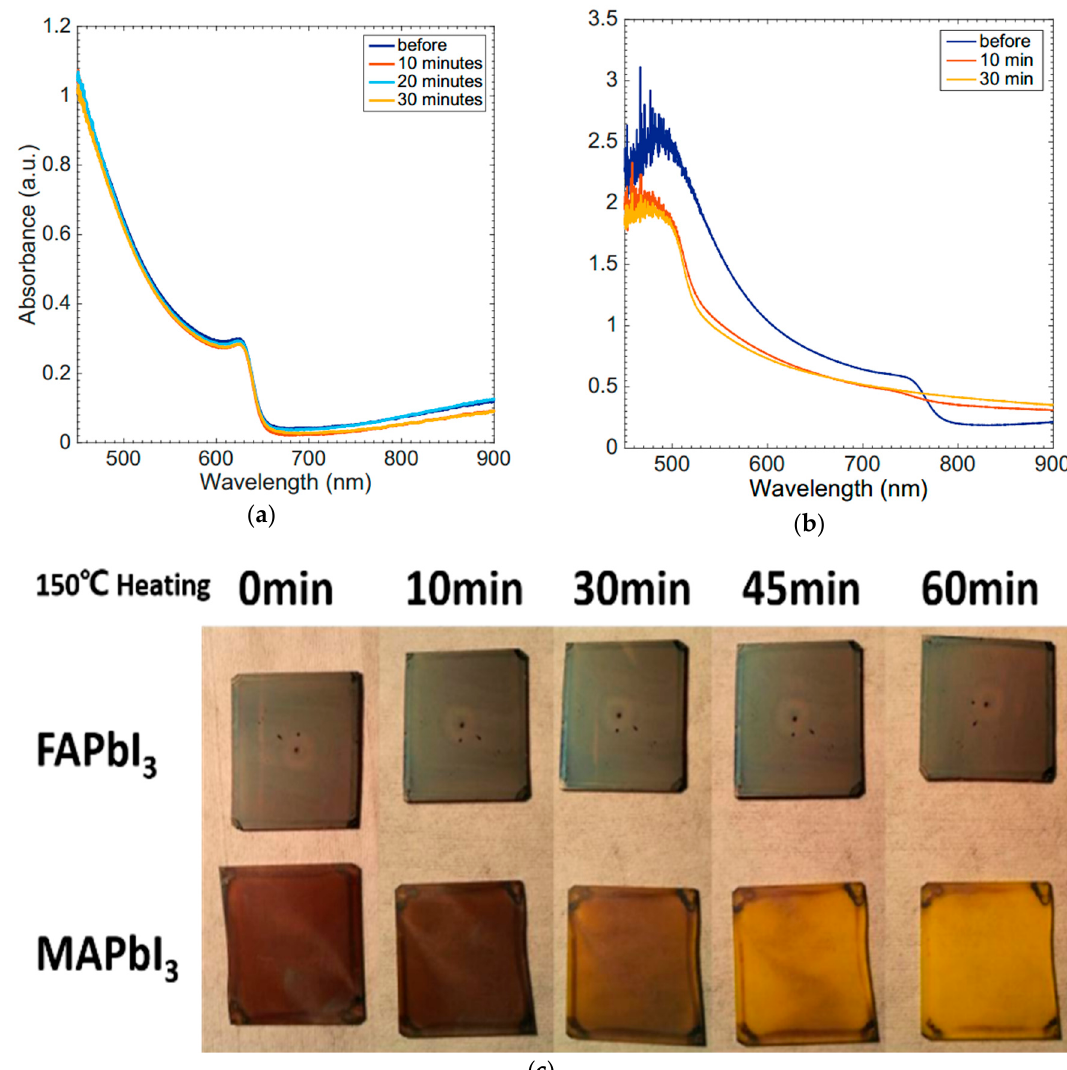
Figure 7. Absorption spectra for CsPbI 2 Br ( a ) and MAPbI 3 ( b ) after heating at 180 °C [78]; ( c ) Thermal degradation of MAPbI 3 and FAPbI 3 , when bare spin-coated films of each perovskite are heated in air at 150 °C for the times indicated [79].